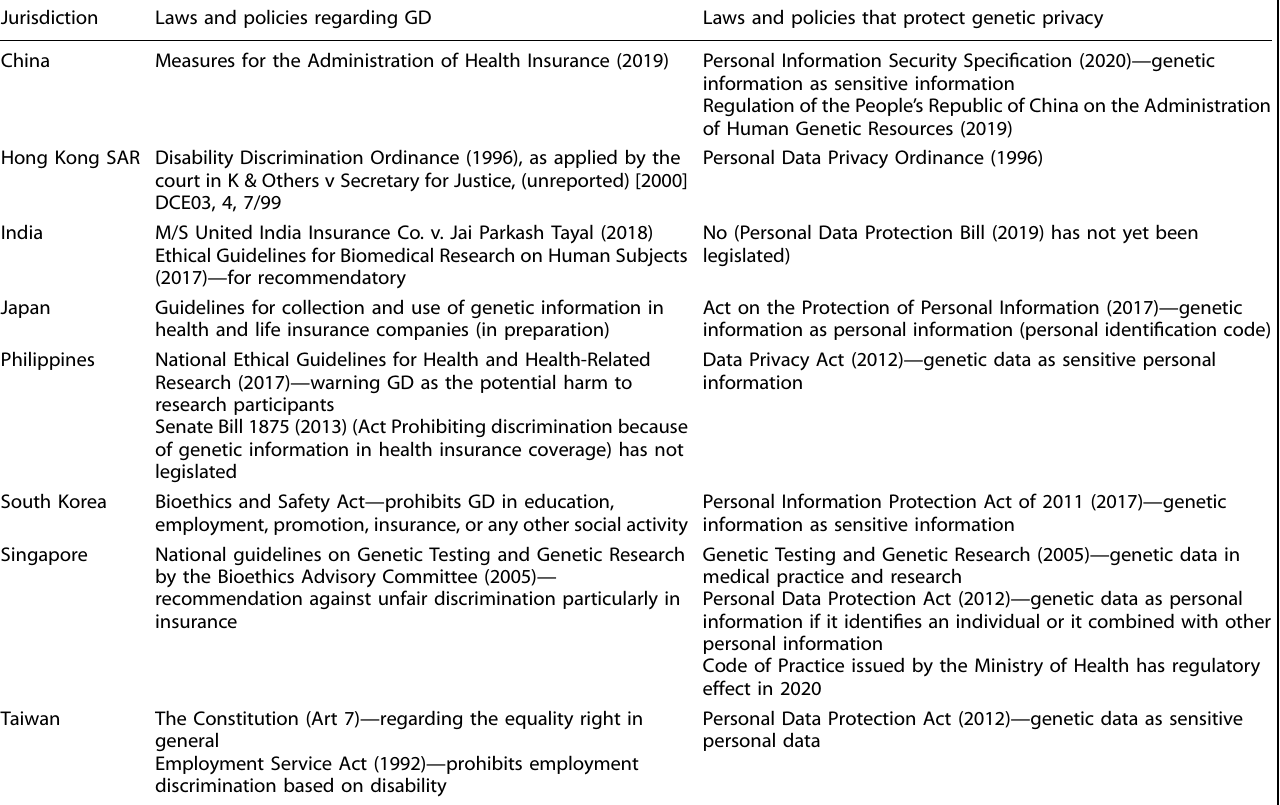
Table 1. Laws and policies that apply to GD and protect genetic